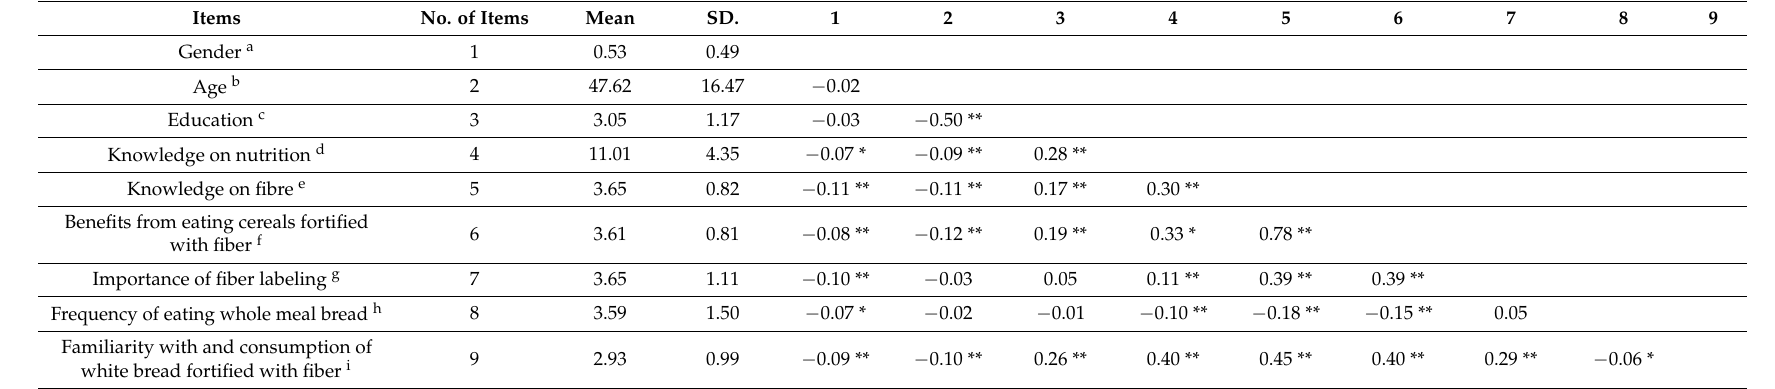
Table 2. Means, standard deviations, and correlations between variables (correlation